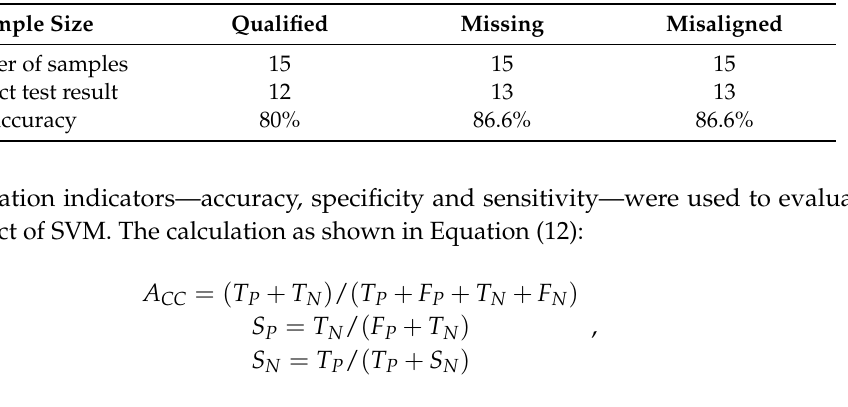
Figure 15. Segmentation results of assembly. ( a ) Example of origin test image; ( b ) example of detection and segmentation results.